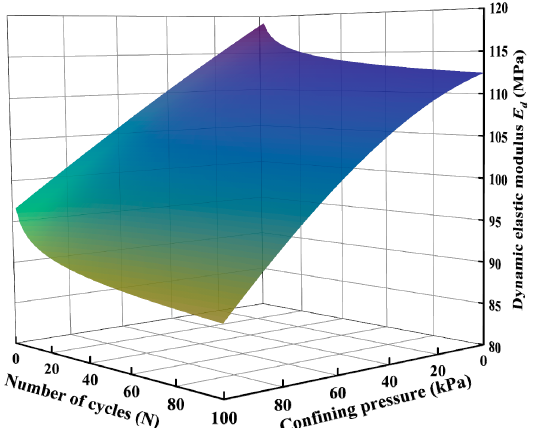
Figure 17. Model diagram of dynamic elastic modulus with confining pressure and cycle times.